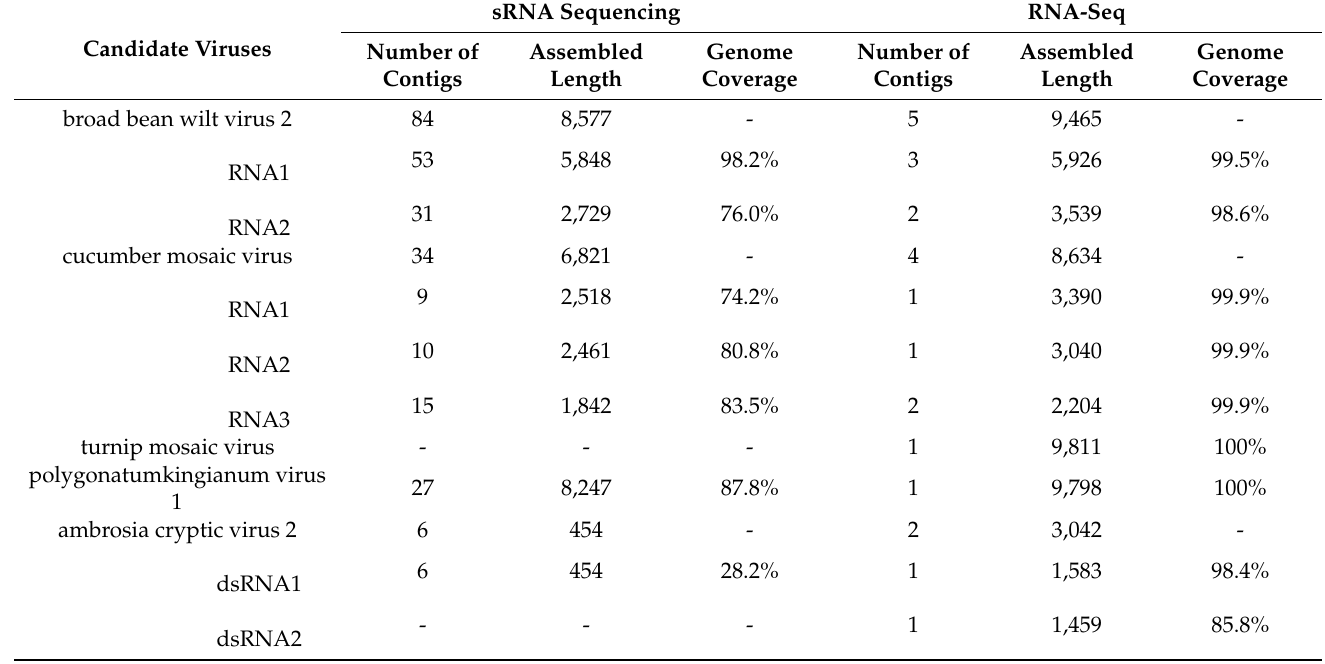
Table 1. Related viruses identified in the deep sequencing data by BLAST